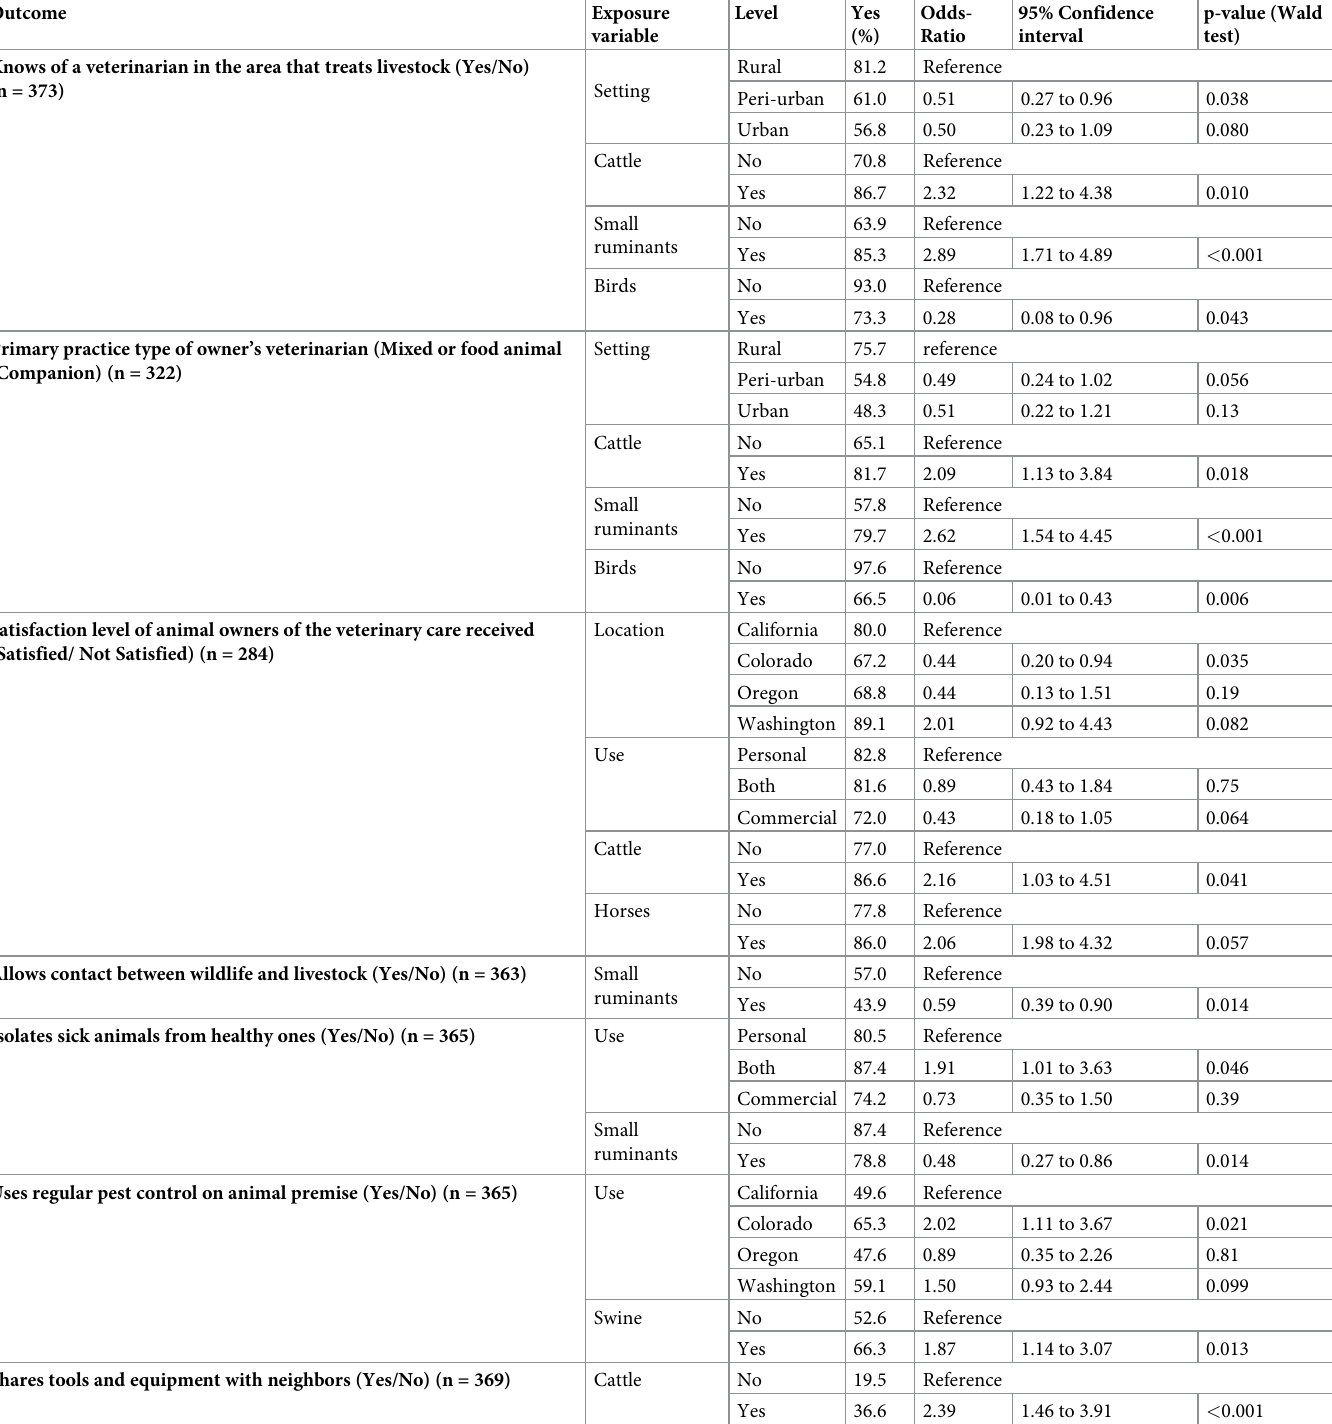
Table 4. Final multivariate logistic regression models investigating the association between veterinary care and biosecurity practices of urban, peri-urban livestock owners and backyard owners in 4 western states (Washington, California, Colorado and Oregon) a . Outcome Exposure